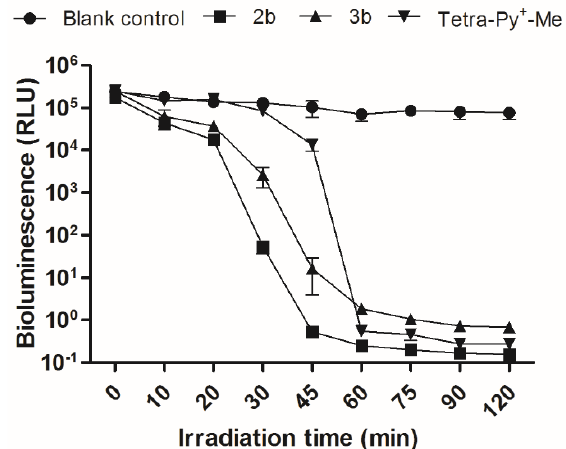
Figure 5 - Bioluminescence monitoring of A. fischeri treated with 10 mM of cationic PSs 2b and 3b and Tetra-Py + -Me after irradiation with white light (400-800 nm) at an irradiance of 100 mW cm -2 during 120 min. Each value represents the mean ± standard deviation of three independent experiments, with two replicates each. Error bars indicate the standard deviation.